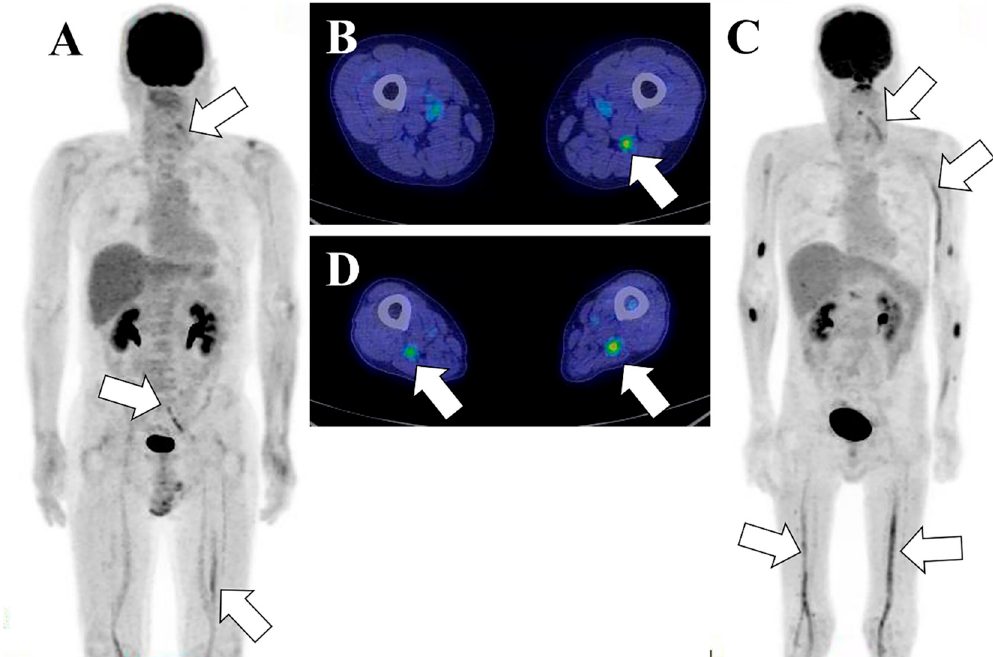
Figure 3. Scatter plot of recurrence proportion by number of affected nerves with regression line .